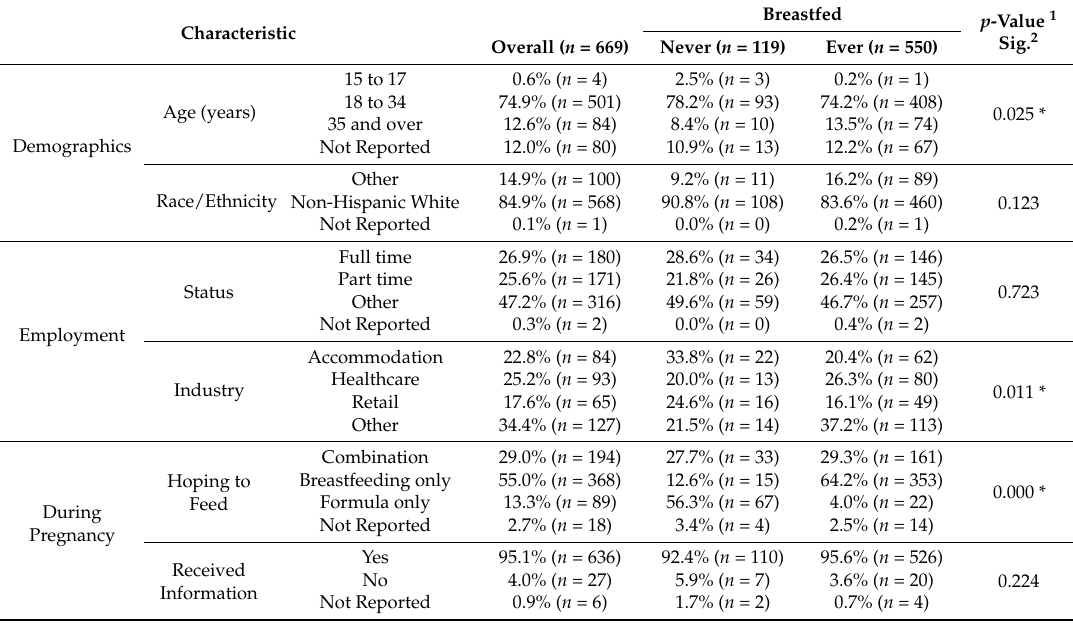
Table 1. Maternal Demographic, Employment, and Pregnancy Characteristics by Breastfeeding Initiation (Never versus